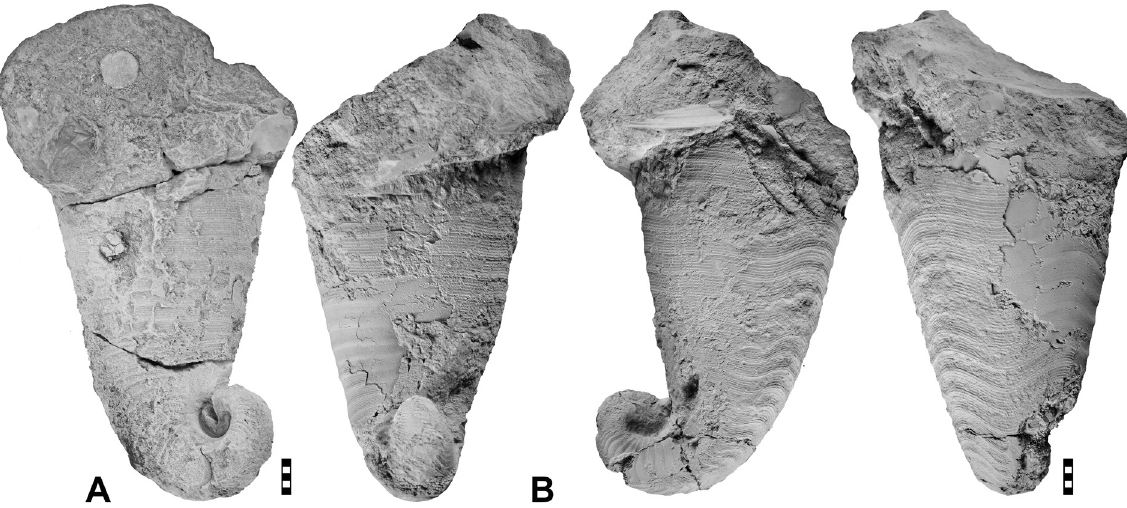
Fig. 25. Ancistroceras torelli (Remelé, 1881) from the Upper Grey Orthoceratite Limestone. A . Lectotype MB.C.22575 from Heegermühle (Brandenburg); dorso-lateral view. B . Specimen MB.C.30519 (Neben & Krueger Coll.) from Schmetzdorf (Brandenburg); dorsal, lateral and ventral views. Scale bar units = 1